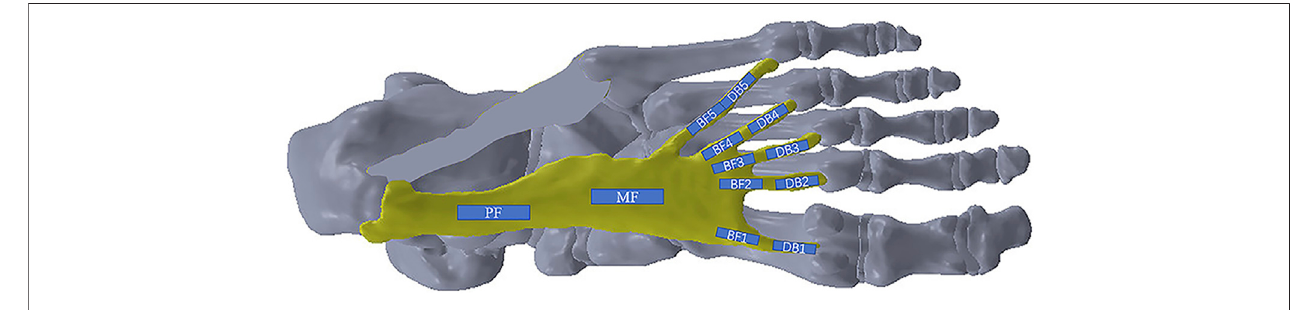
FIGURE 2 | The measuring positions of the plantar fascia.